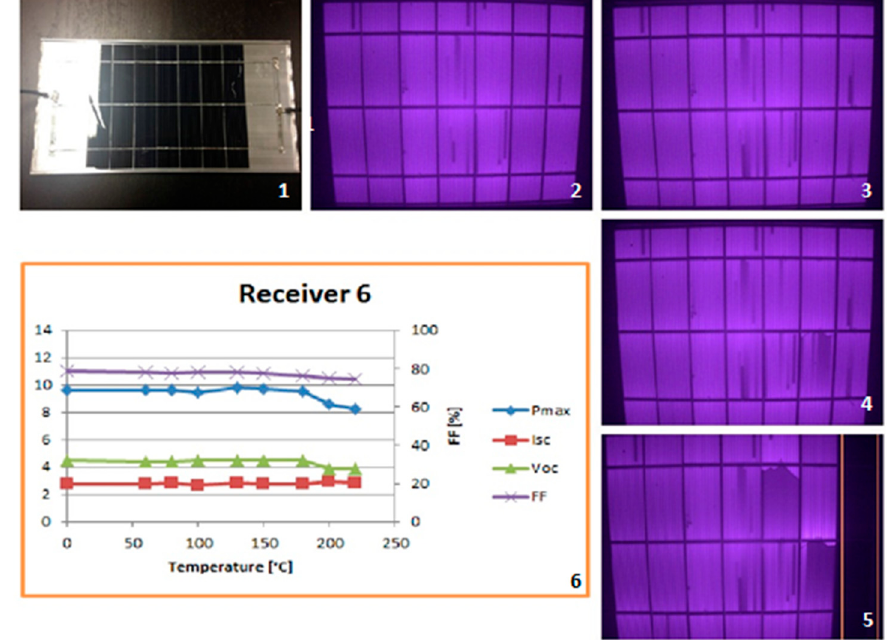
Figure 14. ( 1 ) Receiver 6; ( 2 ) Baseline Round; ( 3 ) Round 5 (150 °C); ( 4 ) Round 6 (180 °C); ( 5 ) Round 8 (220 °C); ( 6 ) Parameters of the IV curve at different temperatures (Isc, Voc and Pmax shown in the left Y axis and FF in the right Y axis).